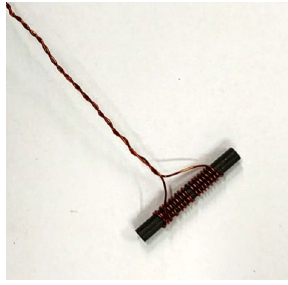
Figure 11. Fabricated uncalibrated magnetic field probe.